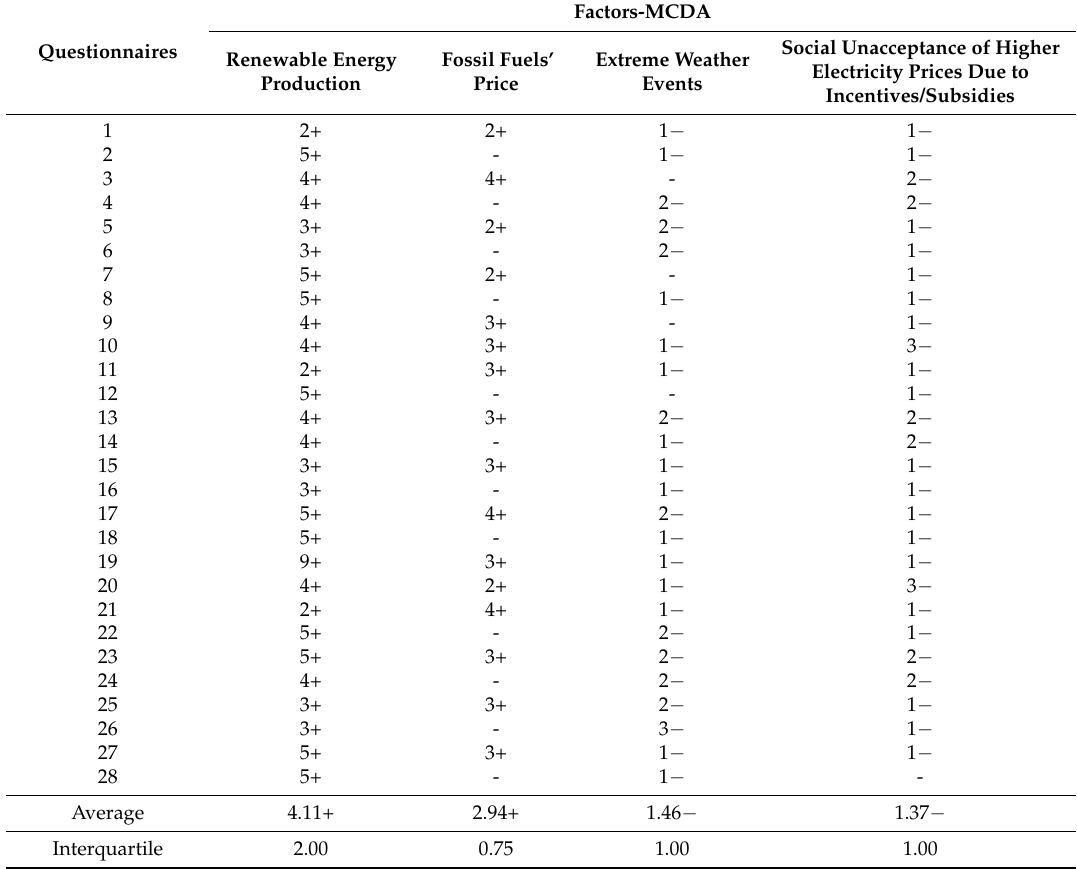
Table A5. Consistency check of the experts’ answers, multiple-criteria decision analysis—interquartile range calculation (last line), empty cells (-) define no answers given.